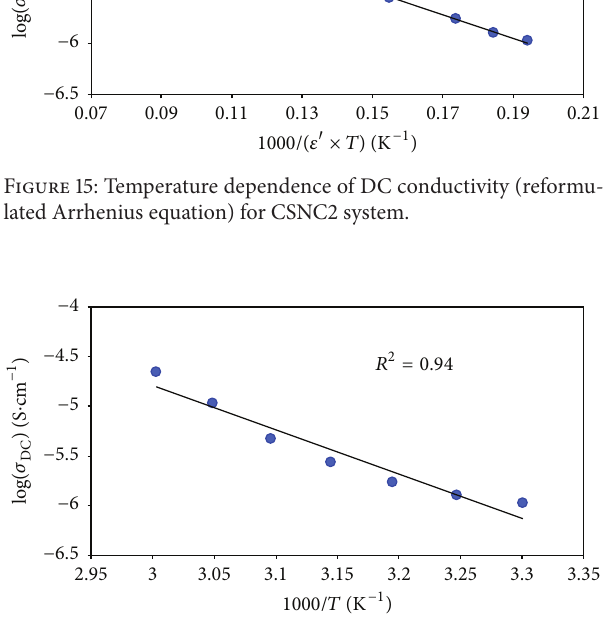
Figure 16: Temperature dependence of DC conductivity (Arrhenius equation) for CSNC2